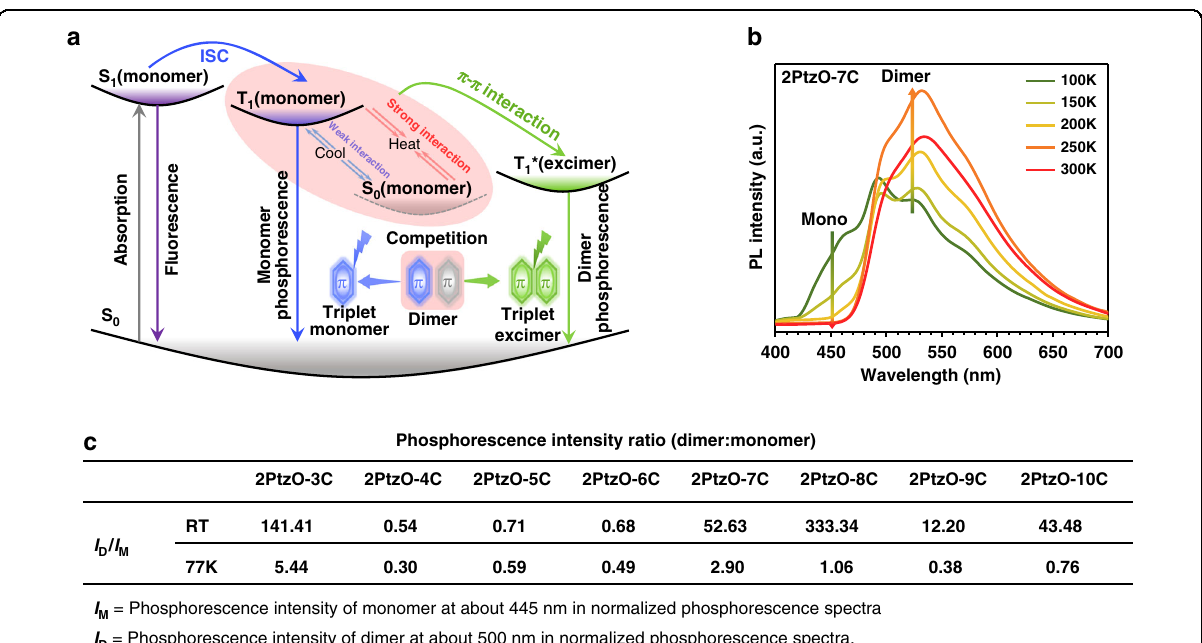
Fig. 4 RTP emission mechanism. a The proposed mechanism for monomer and dimer based RTP emissions: pure excimer RTP emission exists in the dimer with strong π - π interaction and monomer-excimer dual RTP emissions exist in the dimer with weak π - π interaction respectively. b The PL spectra of 2PtzO-7C crystal at different temperatures. c The ratios of dimer to monomer phosphorescent intensity of 2PtzO-nC crystals at room temperature and 77